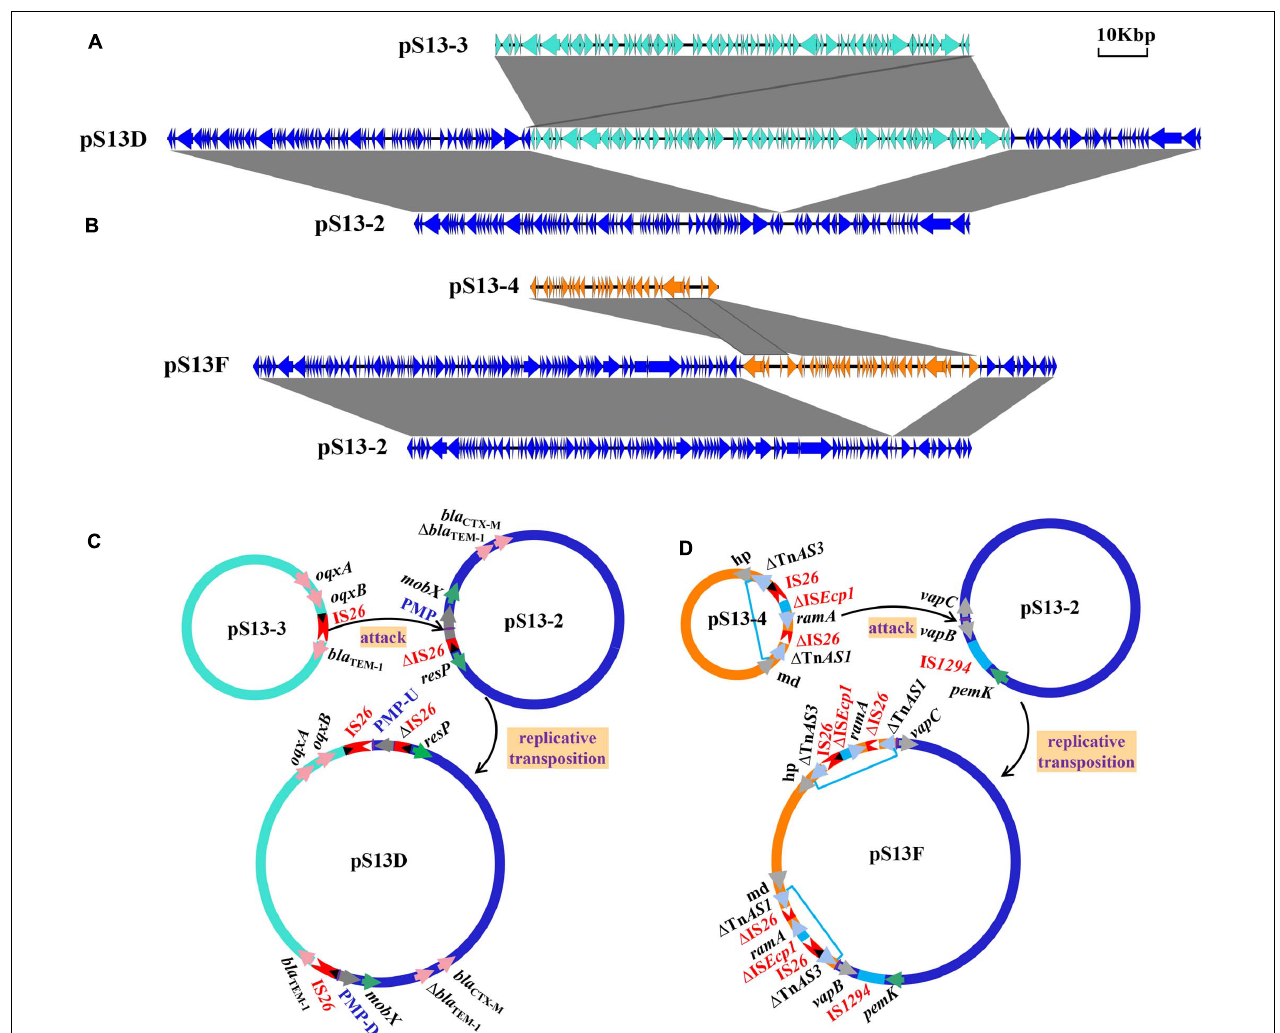
FIGURE 4 | The mechanism of plasmid fusion, including pS13D and pS13F. The shaded area indicates 100% identity. Colored arrows indicate open reading frames, with pS13-2 in blue, pS13-3 in turquoise, and pS13-4 in orange. (A) . Linear sequence comparison of pS13-2, pS13-3, and the fusion plasmid pS13D. (B) . Linear sequence comparison of pS13-2, pS13-4, and the fusion plasmid pS13F. (C) . A model for the formation of pS13D mediated by IS 26 . (D) A model for the formation of pS13F mediated by Tn AS3 -IS 26 - (cid:49) IS Ecp1 - ramA - (cid:49) IS 26 - (cid:49) Tn AS1 . Plasmid names are shown in black. ISs are shown as rectangles (different colors represent different ISs), with triangles representing the terminal inverted repeats (TIRs). Left TIRs, open triangle; right TIRs, closed triangle; pink arrows, resistance genes; gray arrows, proteins. Purple arrows indicate different flanking 8-bp sequences and 5-bp